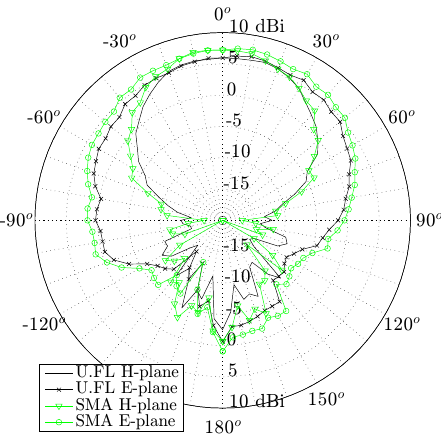
Figure 13. Measured radiation patterns of the U.FL antenna and the SMA